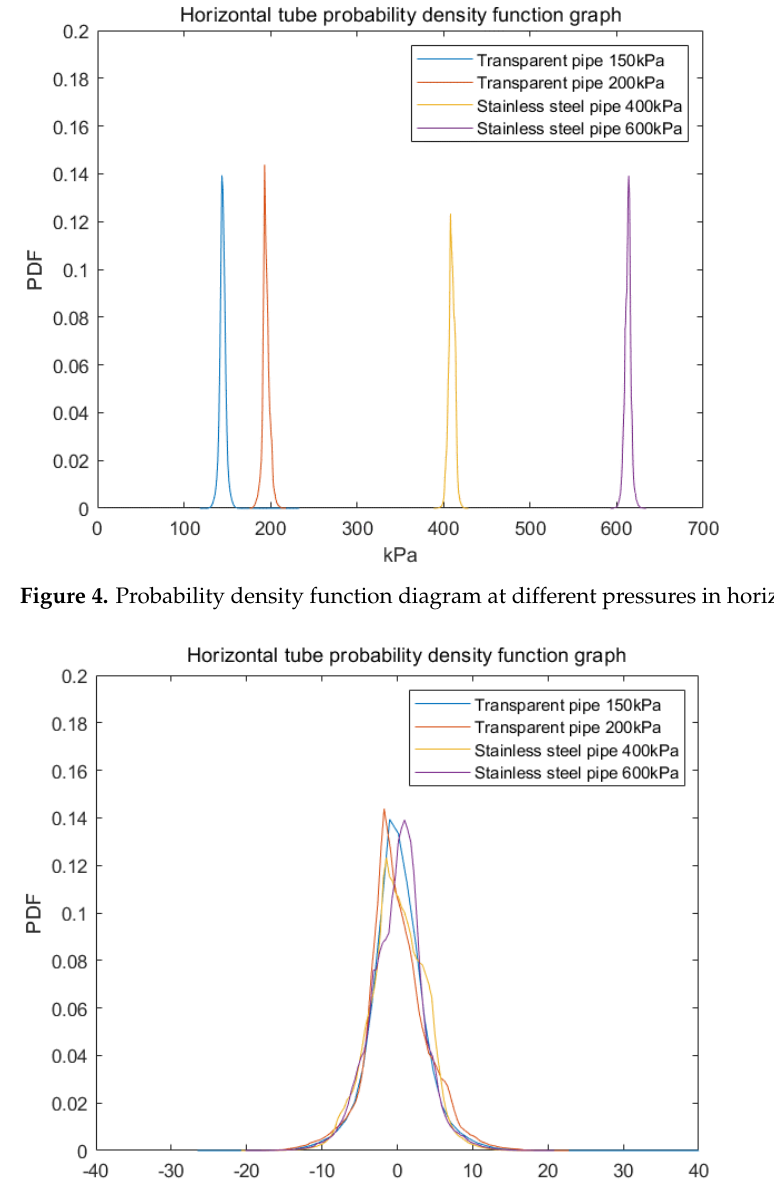
Figure 3. Image after image processing of stratified flow when the pressure is 0.2 MPa.